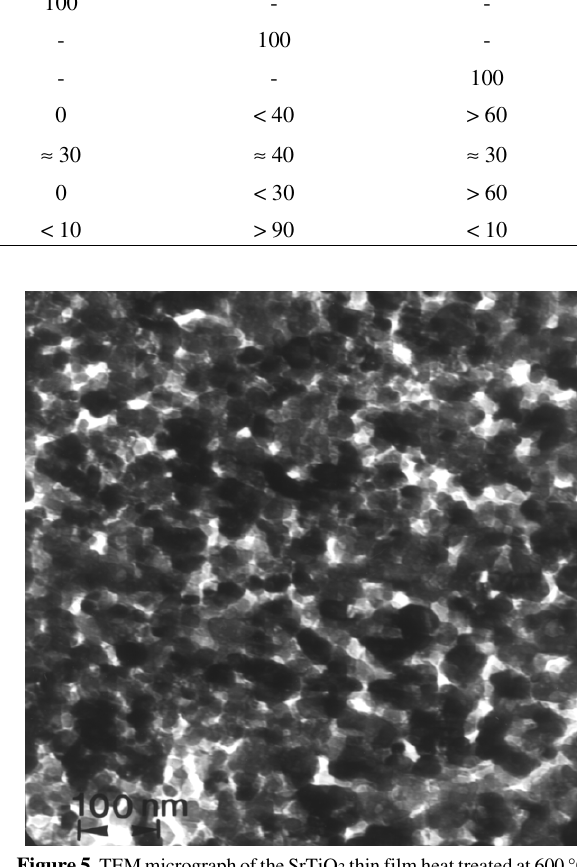
Table 1. 1s → 3d transition position and Ti coordination number for the reference compounds (*) and for the SrTiO 3 samples. Samples